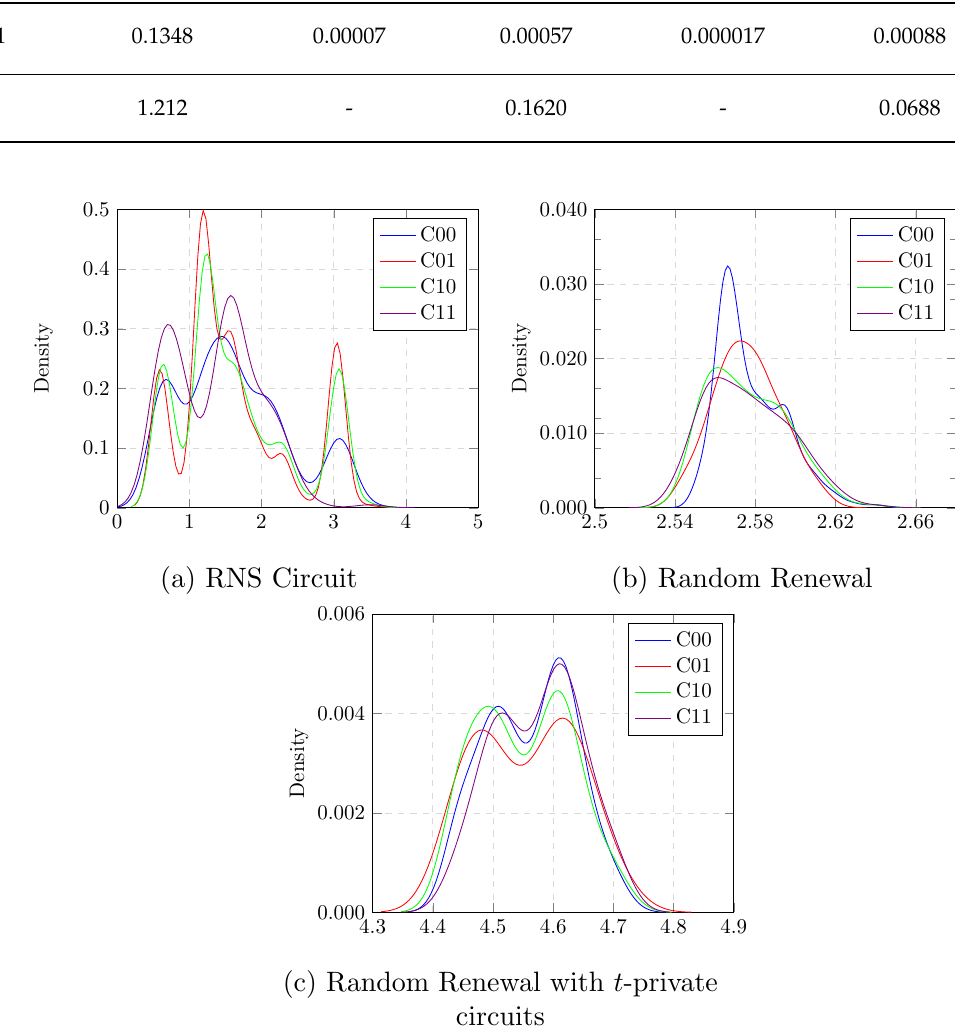
Figure 8. Probability density of maximum